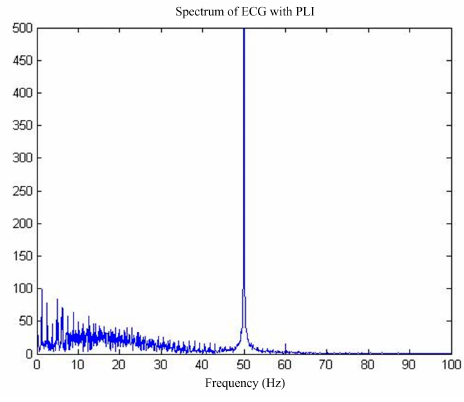
Figure 6. Spectrum of MIT-BIH ECG by PLI.